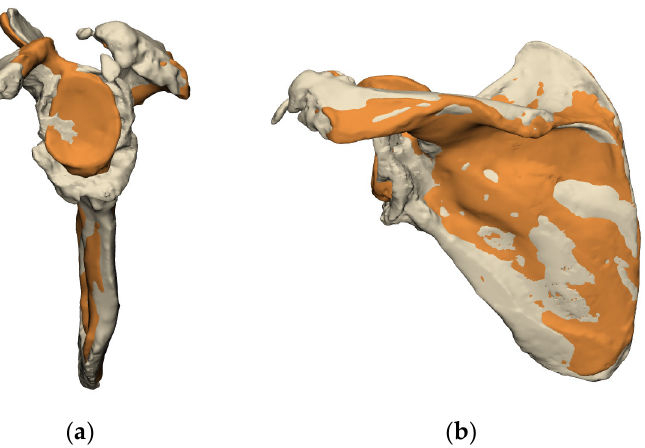
Figure 3. Use of overlaying techniques to assess reconstruction techniques; glenoid enface view ( a ) and posterior view ( b ) (images from Reflect COMPLEX TM (Akunah, Brisbane, Australia)).